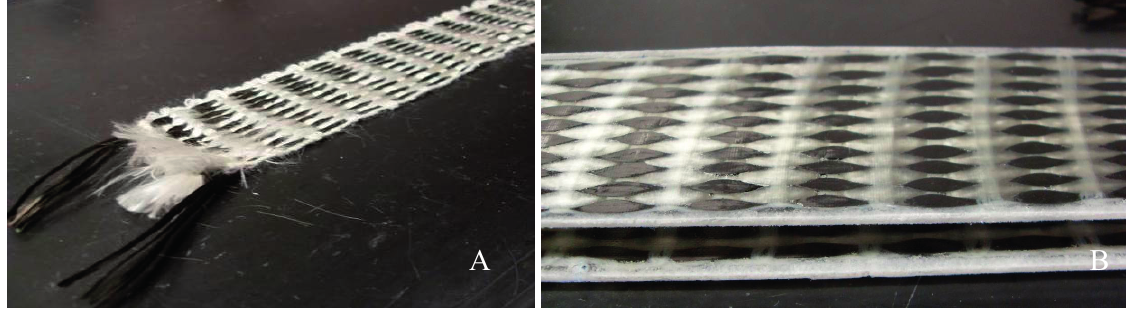
Figure 1. Images of a textile sensor ( A ) and of a woven epoxy composite probe ( B